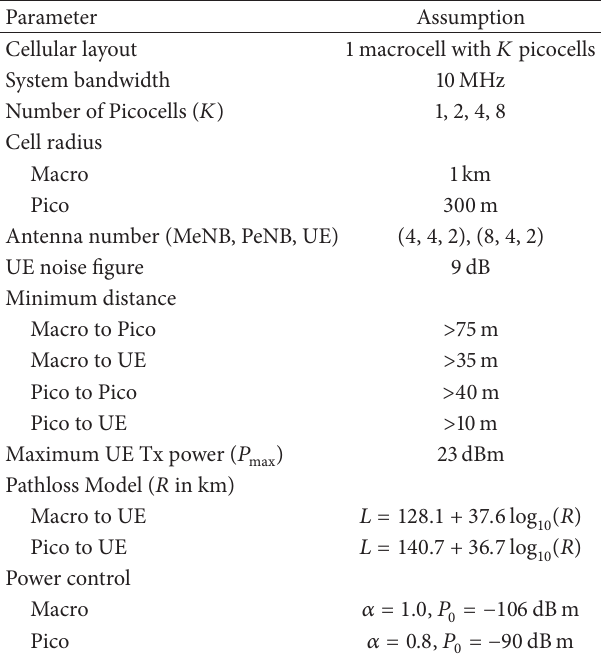
Table 1: Simulation